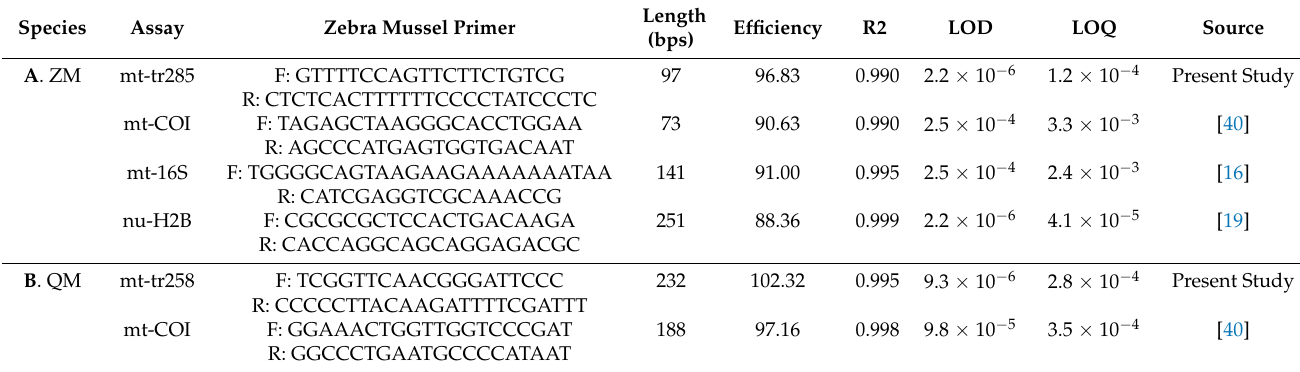
Table 1. Species-specific and/or dreissenid-specific primer pairs (F-Forward and R-Reverse) used for quantitative PCR analysis of environmental DNA for ( A ) zebra mussel (ZM) and ( B ) quagga mussel (QM). The genomic origin (mitochondrial (mt) or nuclear (nu)) is listed for each gene, as well as the length (base pairs), primer efficiency (%), and R 2 for each primer set. Limit of detection (LOD) and limit of quantification (LOQ) are listed in ng of tissue extraction per reaction and were estimated for each qPCR assay using the qPCR_LOD_Calc R script